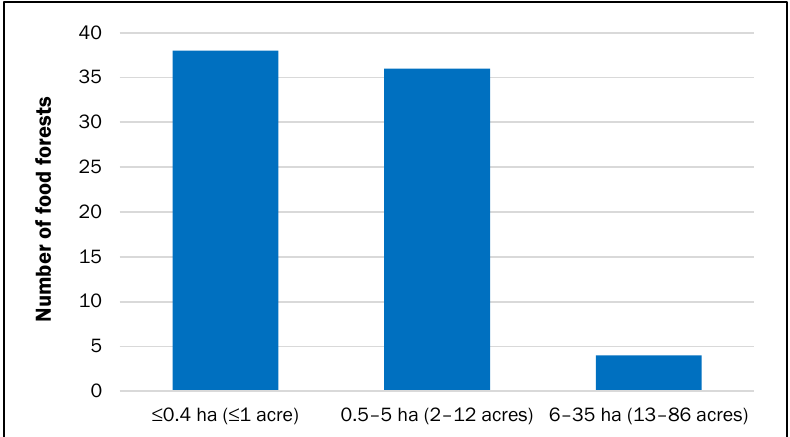
Figure 2. Distribution of Small, Medium, and Large Food Forests ( n =78)